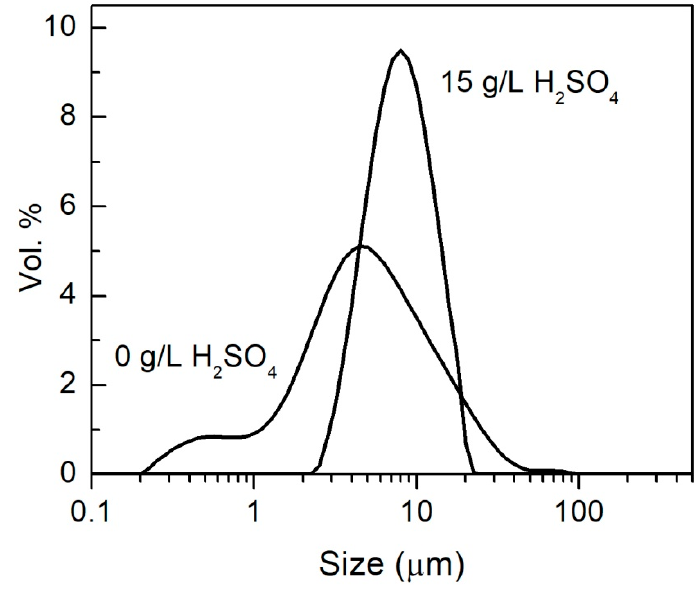
Figure 7. Particle size distribution of the precipitates: Other solution conditions: 6 g/L Fe(III), 30 g/L Cu(II), 11g/L Cl¯, 1 h, 150 °C.